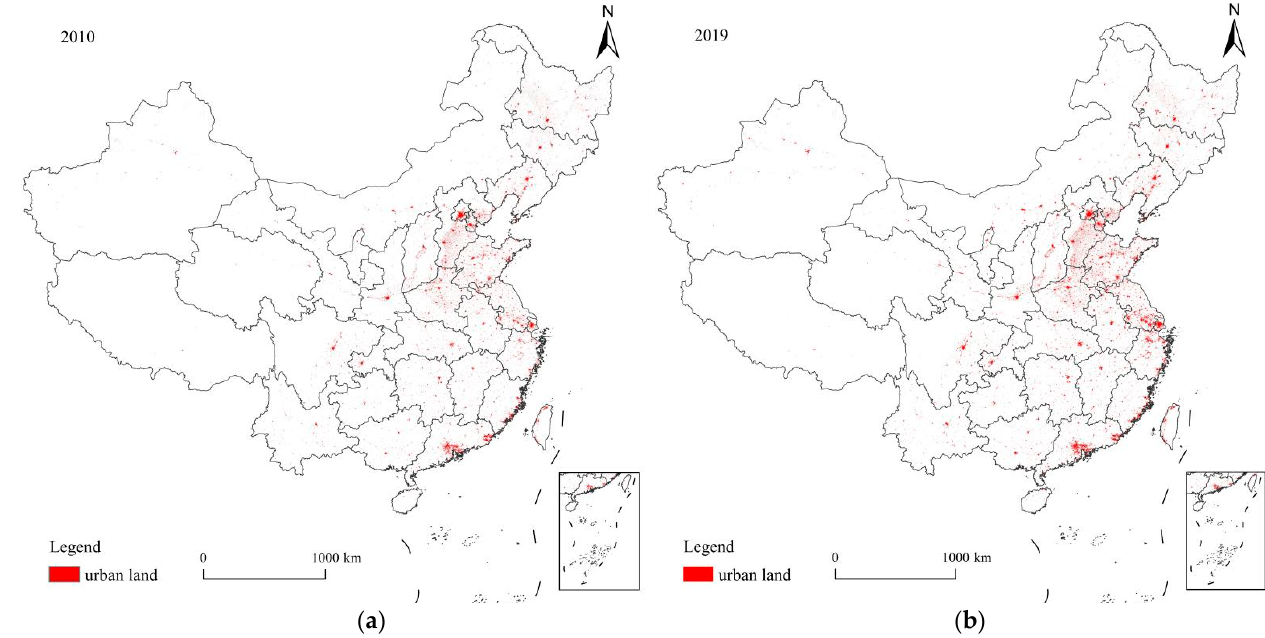
Figure 3. The distribution of urban land in China.